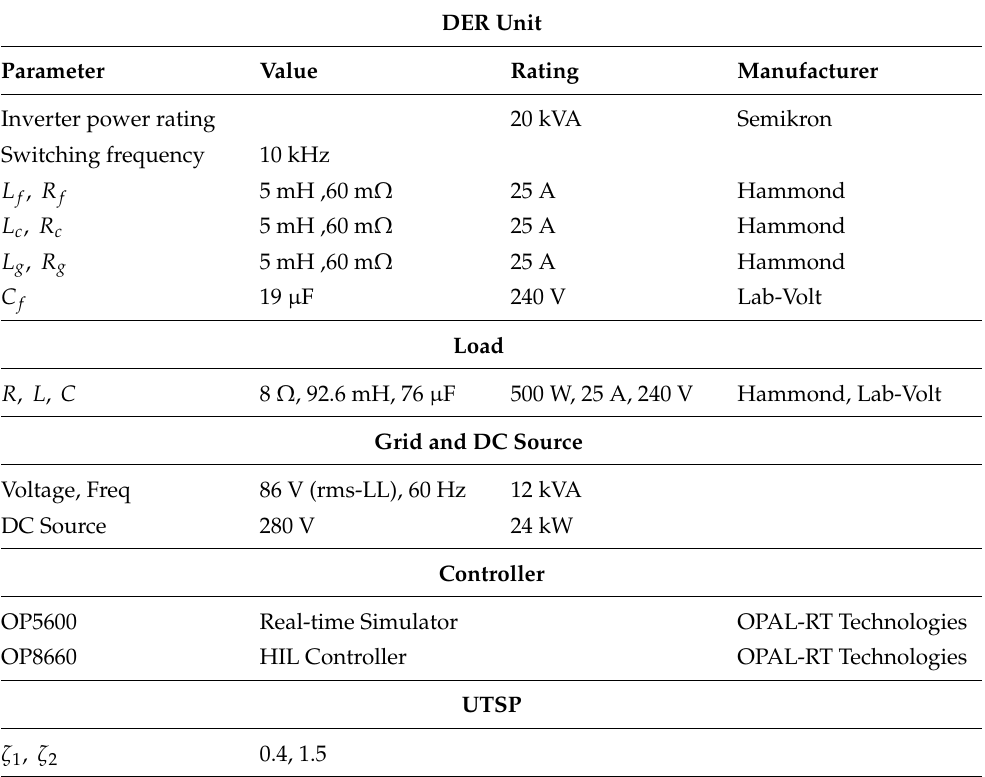
Table A1. Parameters of the experimental setup of Figure